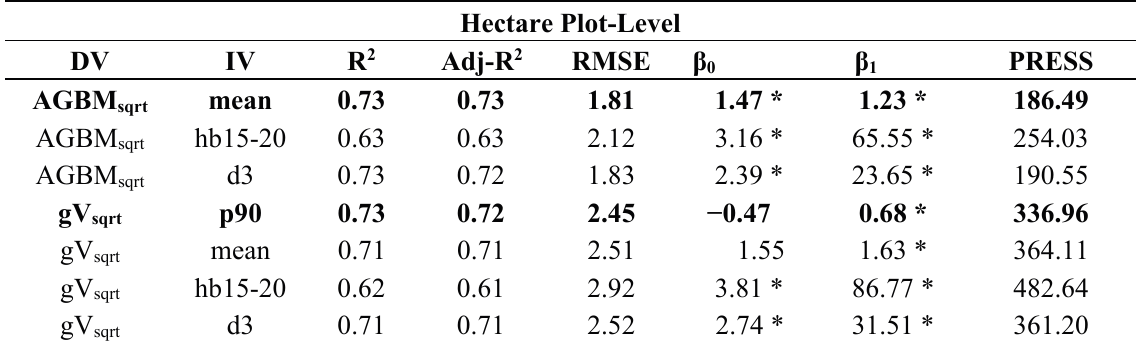
Table 9. Summary of the best hectare plot-level aboveground biomass and gross volume simple linear regression models for each point cloud metric set. * indicates p-values of less than